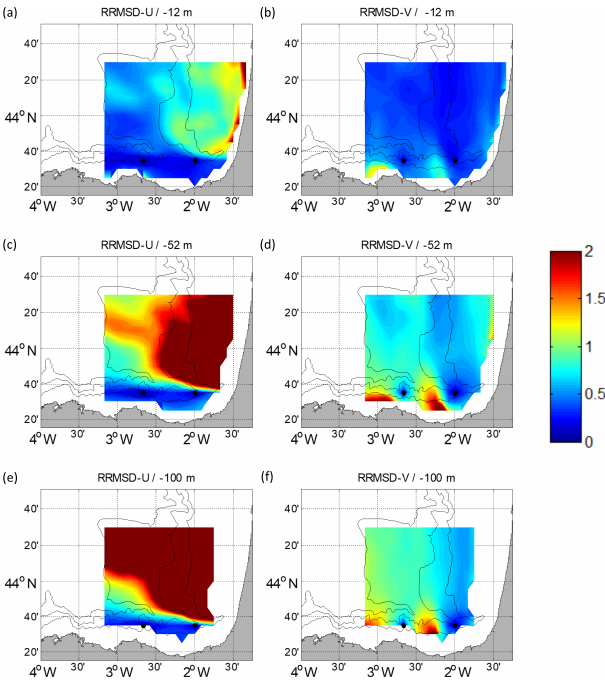
Figure 9. RRMSD maps for the winter period between the reference fields and the outputs of the DCT-PLS for U (a, c, e) and V (b, d, f) . Different depths are considered: − 12m (a, b) , − 52m (c, d) and − 100m (e, f) . The black dots depict the locations of the current vertical profiles.